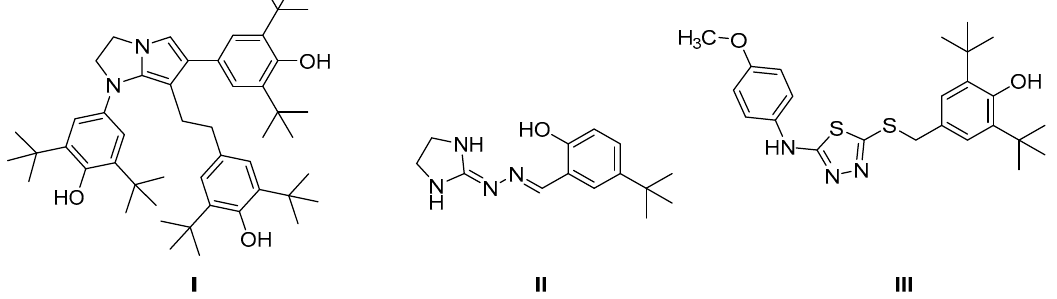
Figure 1. Examples of substances, exhibiting antibacterial activity.